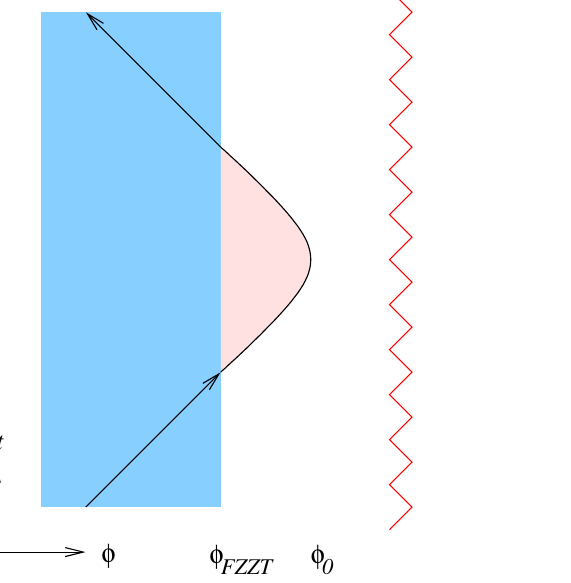
Figure 2. Long folded strings on FZZT branes. The region φ < φ FZZT where the boundary Liouville potential is small is illustrated in blue. The long string stretches from φ FZZT to φ 0